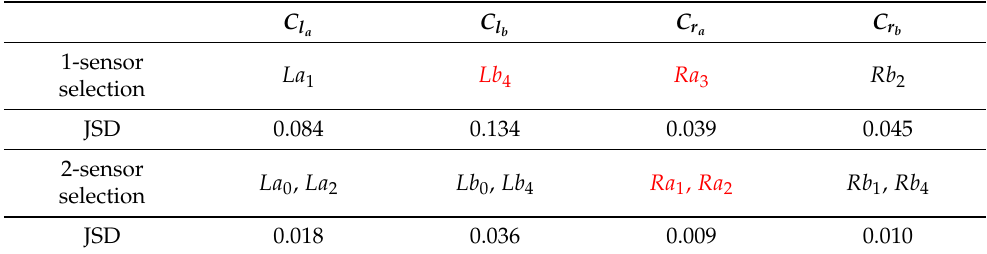
Table 3. The sensor selection with the smallest JSD among all choices. The different choices between Tables 2 and 3 are marked in